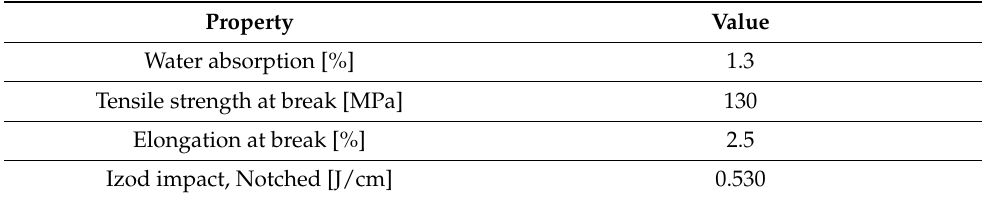
Table 2. The properties of MF 25%/GF 15% reinforced PA6.